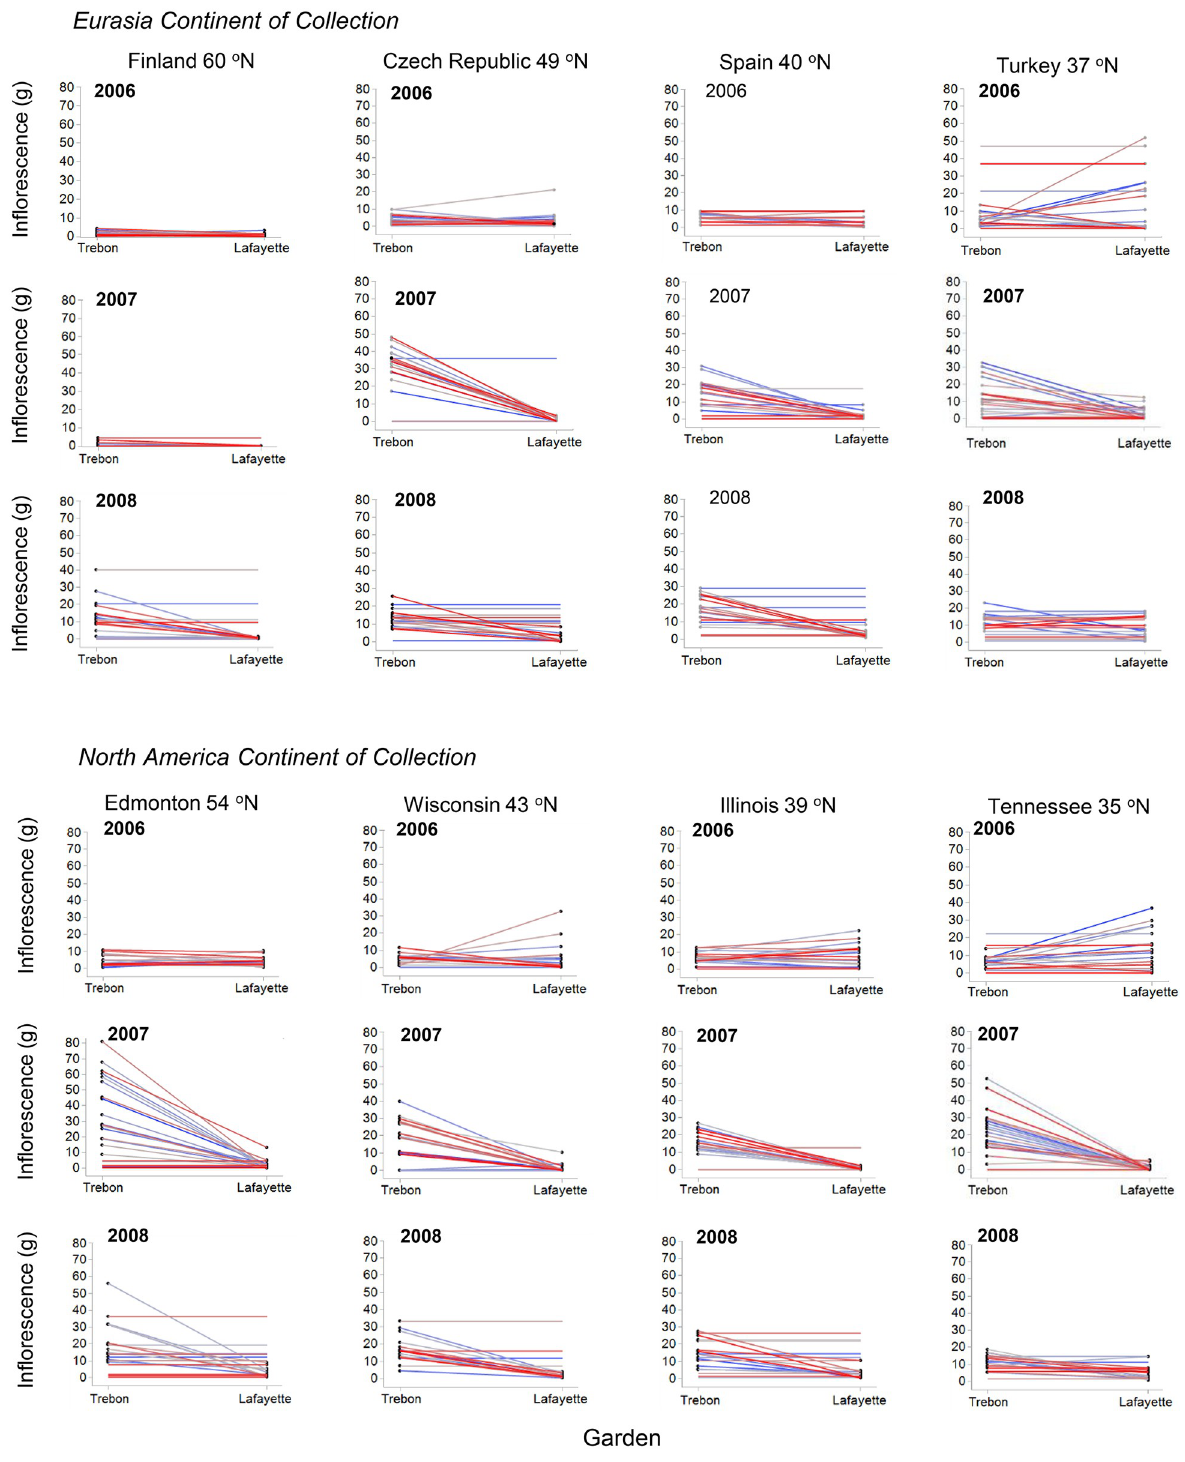
Fig 3. Reaction norms for log inflorescence biomass (g) constructed from plants grown from the seeds of the same maternal plant grown in the gardens in T ř ebo ň Czech Republic and Lafayette Louisiana (cold vs. hot garden) in 2006–2008. Individual maternal plant numbers are depicted by a gradient of blue to red